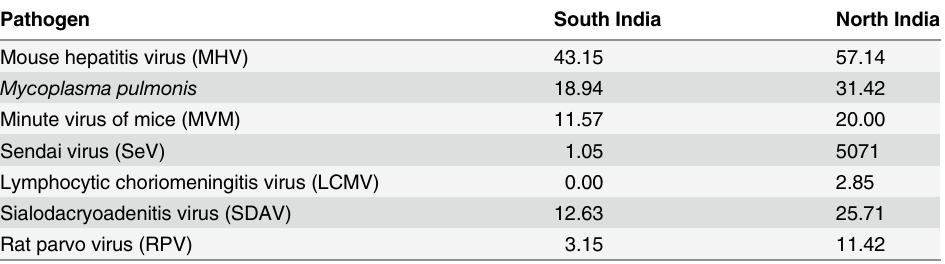
Table 3. Incidence (%) of mouse and rat pathogens in North (35 samples) and South (95 samples) India.